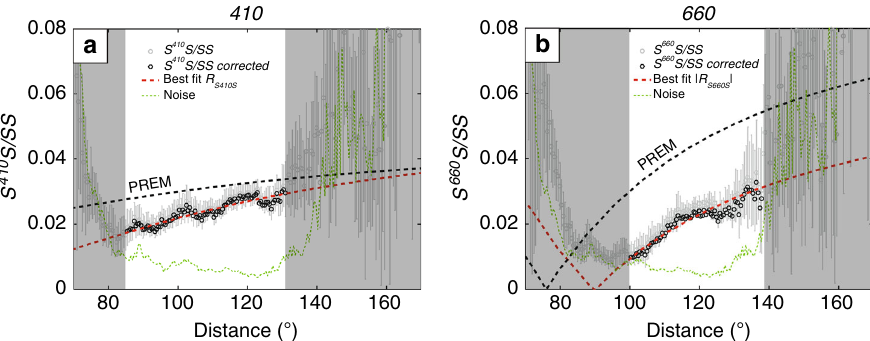
Fig. 3 Precursor amplitudes as a function of distance. a and b are for 410 and 660 , respectively. Dashed black and red lines are S 410 S and S 660 S re fl ection coef fi cients calculated from PREM 27 and estimated for the study region, respectively. Gray circles are measured amplitude ratios, with 2 σ uncertainties estimated from bootstrapping 48 . Green dashed lines depict background noise (estimated in a time window [600 – 350] s before SS ). Re fl ection coef fi cients are inferred from amplitude ratios upon correction for geometric spreading, intrinsic attenuation, and incoherent stacking, and only the most reliable coef fi cients (black circles in the white sections) are used to constrain Δ β and Δ ρ . Red curves show the best fi t based on grid search in ( Δ β , Δ ρ )